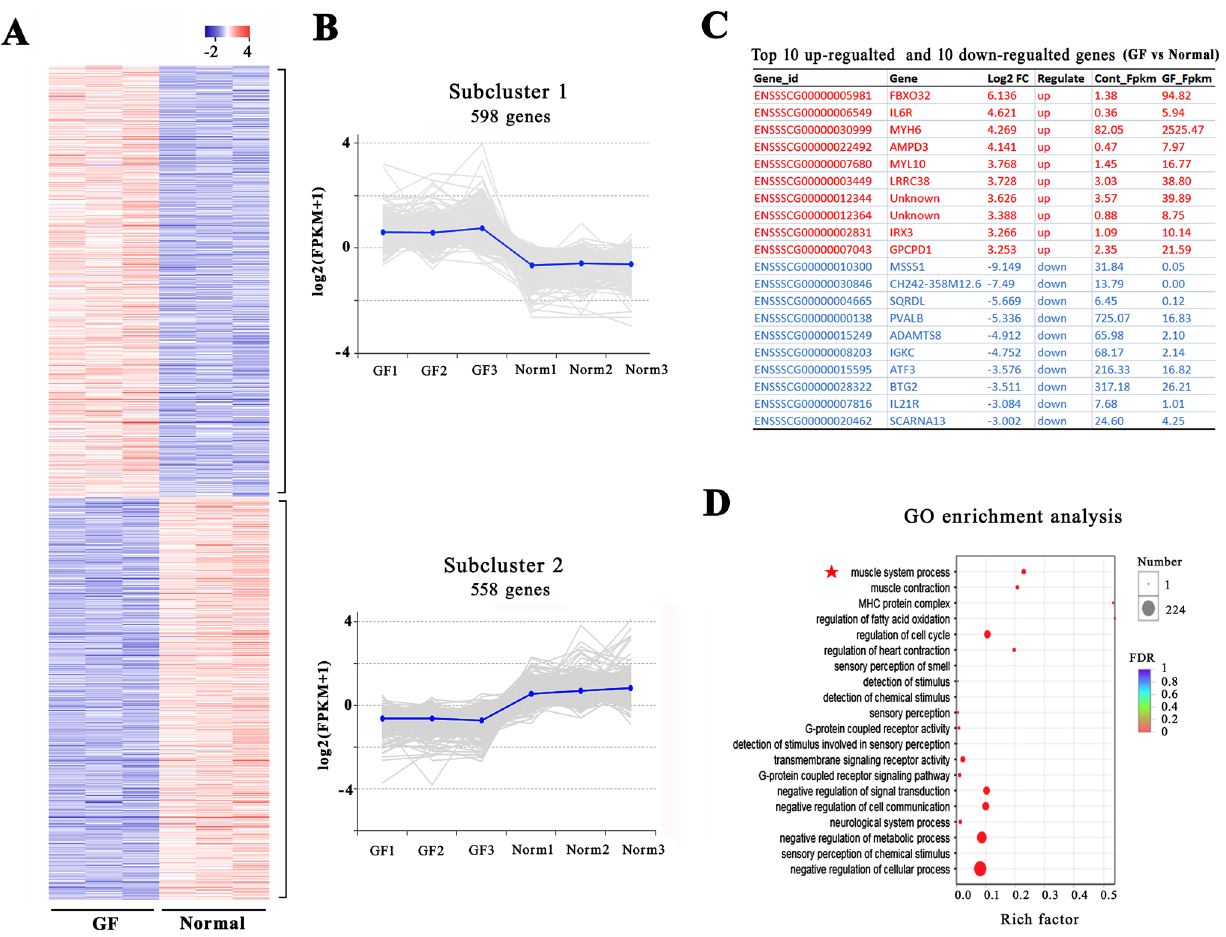
Figure 4. RNA-seq analysis of protein-coding gene expression in the muscle tissues of GF piglets and normal piglets. ( A ) Heatmap of 1156 significantly differentially expressed genes (DEGs). The red dots and the blue dots indicate up- or downregulated genes with fold changes > 2.0 and P adjusted < 0.05. ( B ) Abundance patterns of the genes segregated into two clusters after k-means analysis. ( C ) Top 10 upregulated genes and 10 downregulated genes in the muscle tissue of GF piglets vs. normal piglets. ( D ) DEGs enriched in the GO term muscle system